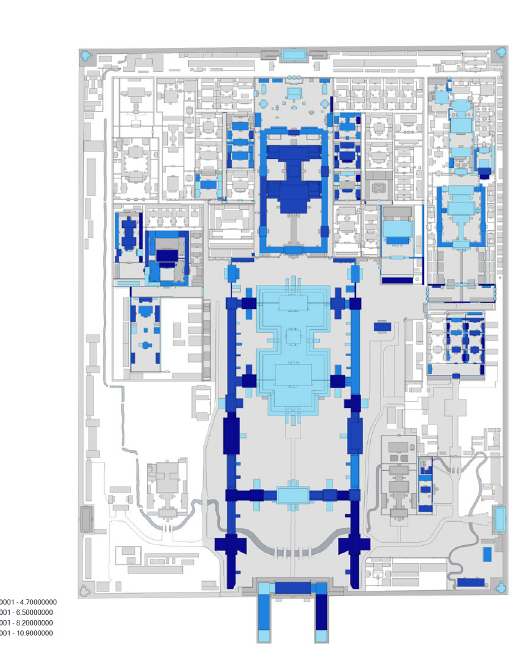
Figure 10. The distribution of